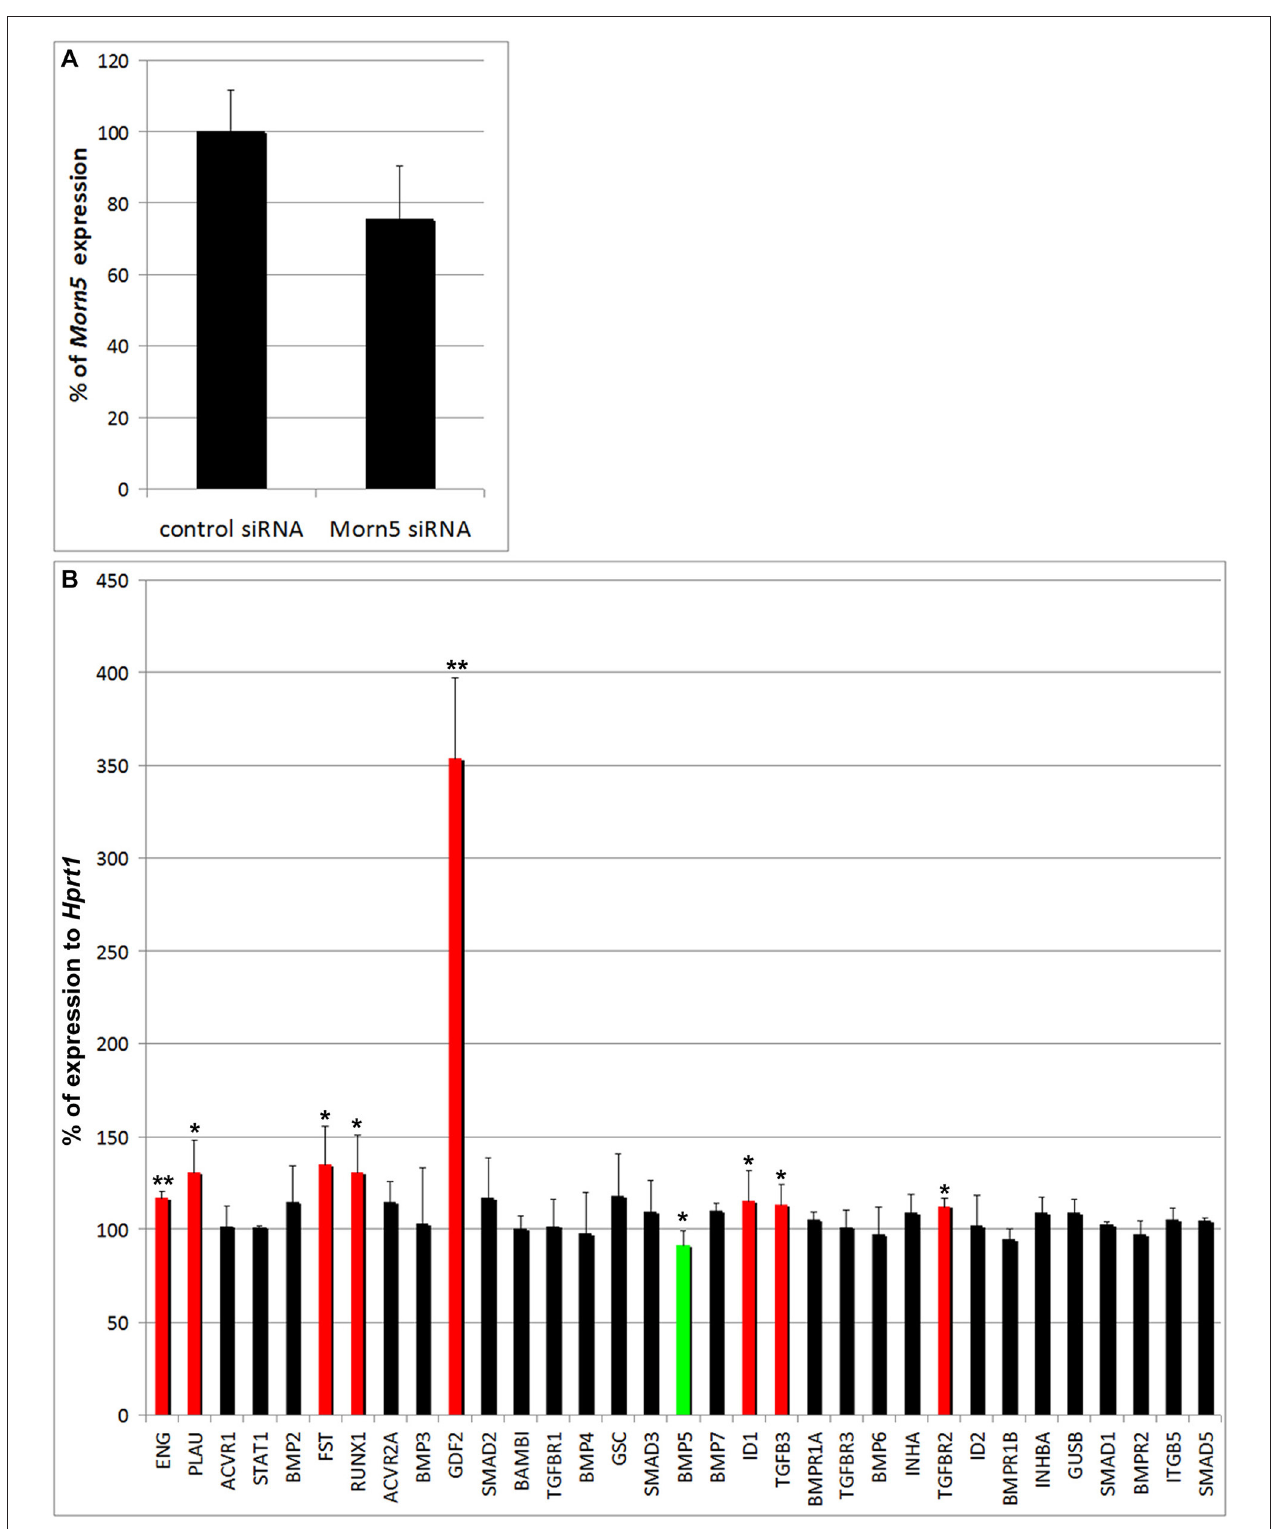
FIGURE 9 | BMP pathway gene expression after MORN5 downregulation. (A) Downregulation of MORN5 expression after siRNA treatment. (B) MORN5 downregulation caused significant increase in GDF2, ENG, TGFBR2, TGFB3, PLAU, FST, RUNX1, and ID1 expression. Statistically significant downregulation was observed only in case of BMP5 . t -test; **0.001 < p < 0.01, * p < 0.05.